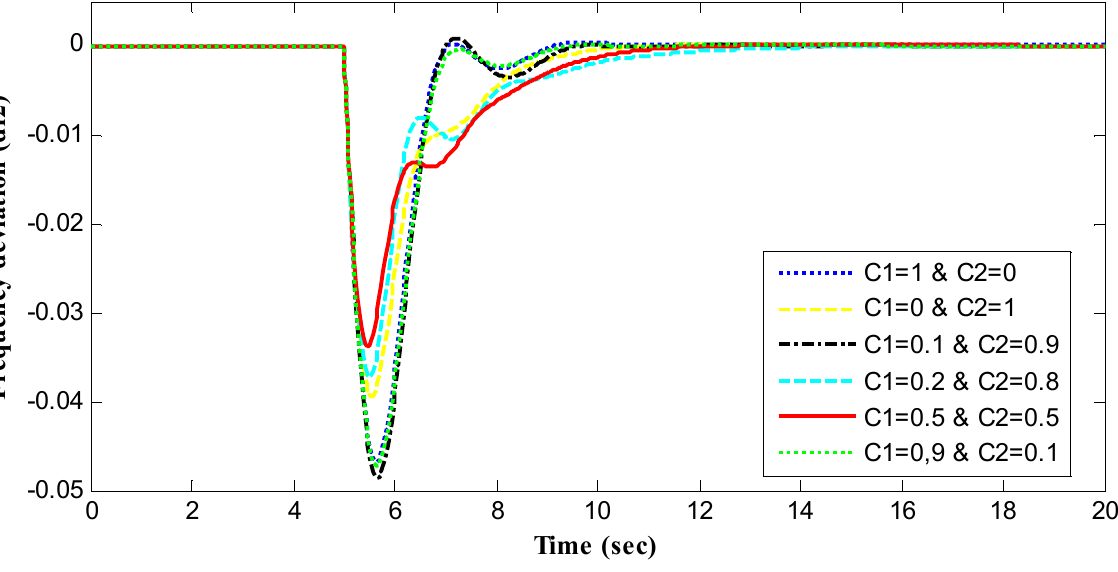
Figure 10. Frequency deviation ∆ f 2 for area 2 using the proposed IB-WGFF.